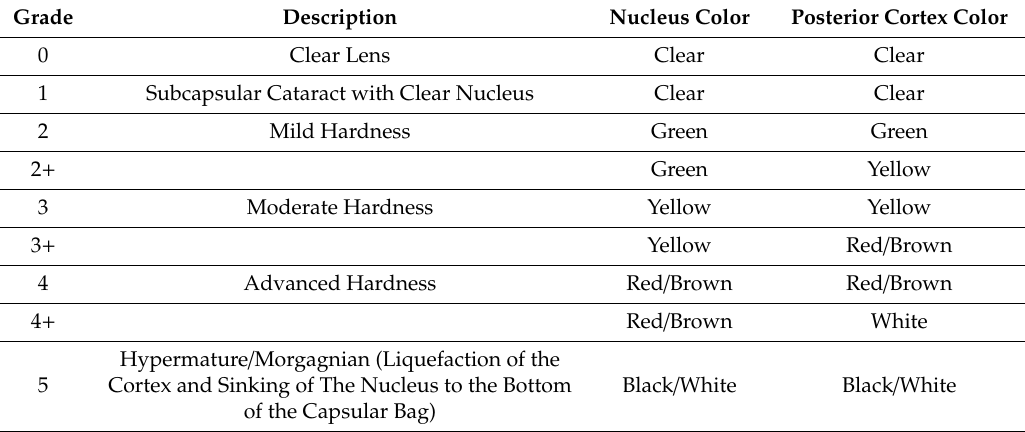
Table 3. Description of the Simple Pre-operative Nuclear Classification System